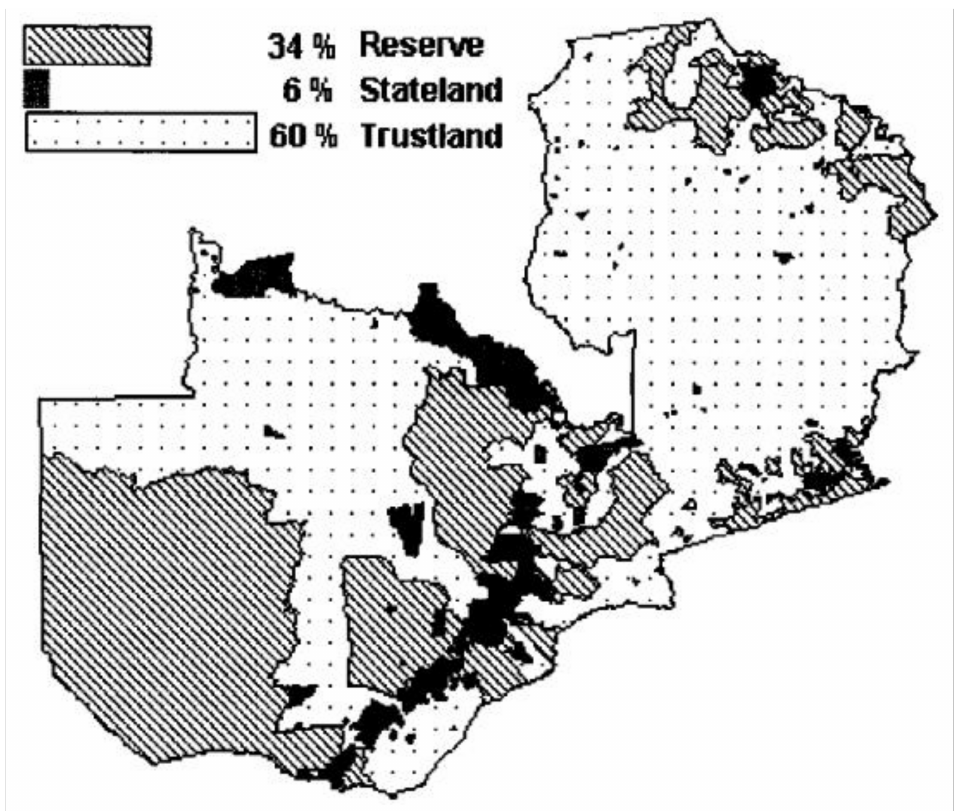
Figure 2. Distribution percentage of crown land, native reserve, and trust land during the Colonial era in Zambia [63] (p.